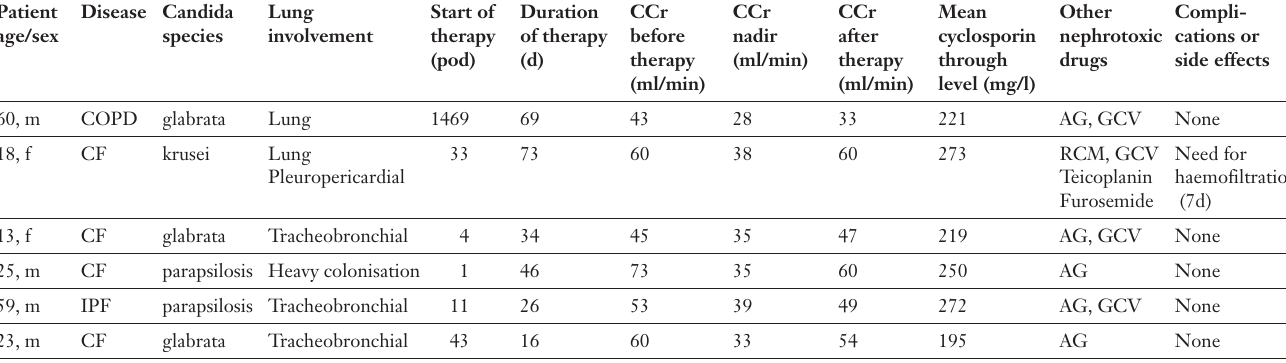
Table 1 Patient characteristics (n = 6), treatment, clinical course, and renal Patient Disease Candida